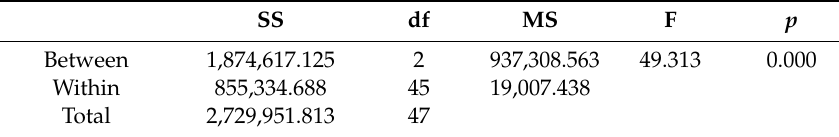
Table 3. The analysis of variance (ANOVA) result of the total assembly